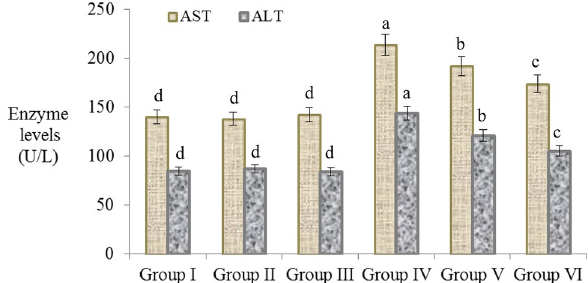
Figure 2. The effects of AFB2 and resveratrol on the levels of AST and ALT, indicator enzymes of liver injury. Group I: control, Group II: 10 mg/kg b.w resveratrol, Group III: 20 mg/kg b.w resveratrol, Group IV: 20 µg/kg b.w AFB 2 , Group V: 10 mg/kg b.w resveratrol + 20 µg/kg b.w AFB 2 , Group VI: 20 mg/kg b.w resveratrol + 20 µg/ kg b.w AFB 2 . Values are shown as mean ± SD (n = 6). Each histogram is a decimal average. The vertical lines on the bars indicate the standard error. Different letters (a–d) indicated averages p < 0.05 is important.